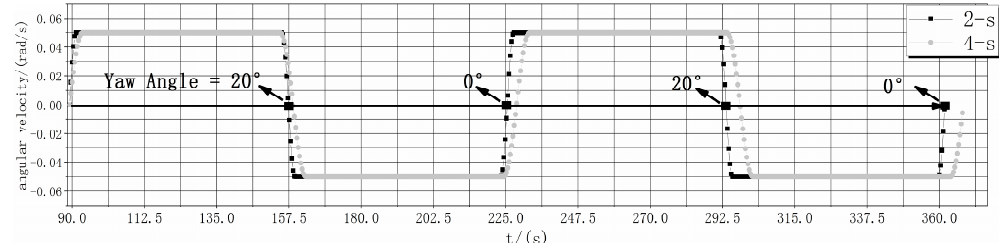
Figure 6. Variation of yaw velocity under different transient start-stop processes.